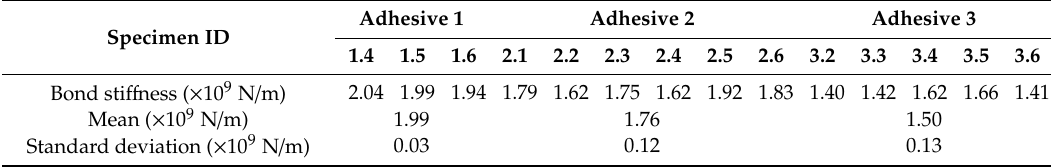
Table 3. Values of the bond sti ff ness K calculated by linear regression of the load vs. displacement